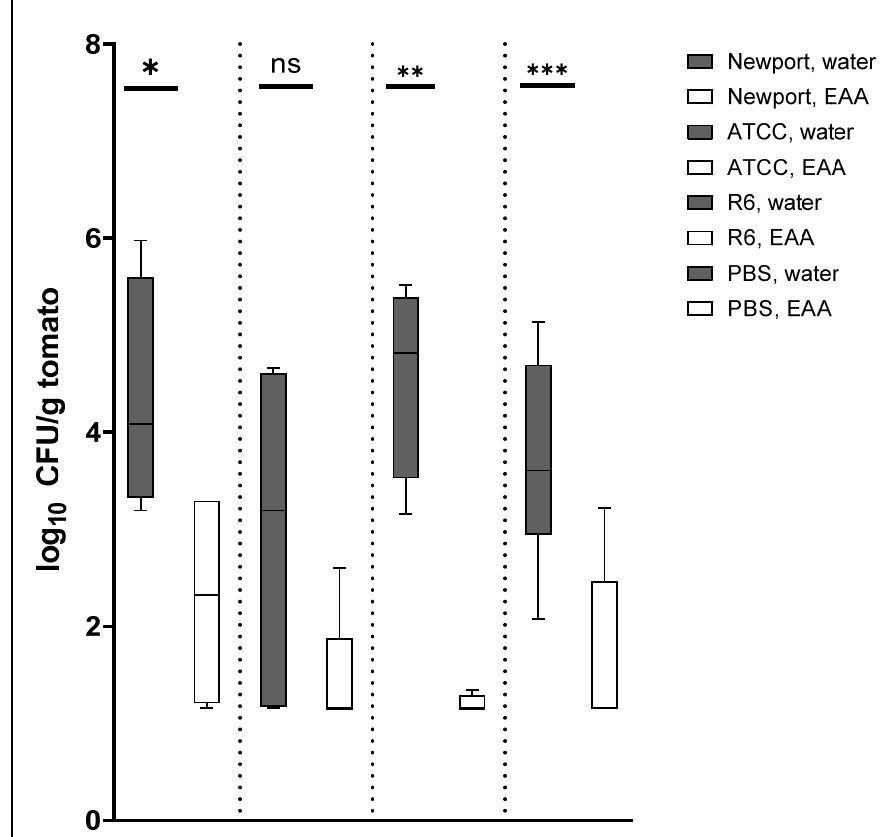
Figure 2. Effect of EAA on externally added S. enterica and naturally occurring background flora. Newport, S. Newport MDD14; ATCC, S. Typhimurium ATCC 19585; R6, S. Typhimurium FSL R6- 0020. The log 10 CFU/g tomato data are plotted for each of the samples (grey bars, H 2 O white bars, EAA). The S. enterica counts were taken from the SSA plates, the counts for naturally occurring background flora from the PBS tomatoes were taken from the PCA plates. The asterisks are indicative of the significance of the p -values from the t -test in ranked order (*** 0.0009, ** 0.0033, * 0.025, ns not significant).